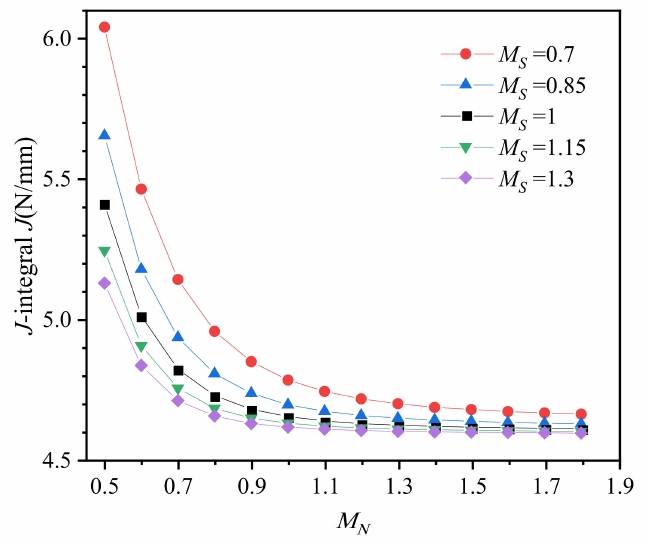
Figure 8. J -integral with different strength and strain hardening